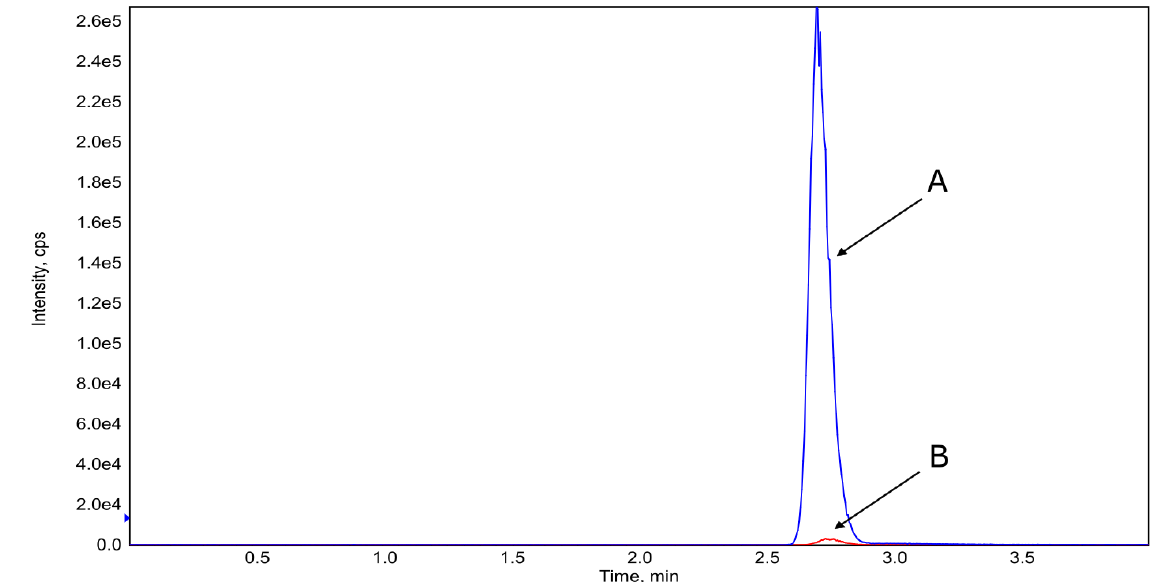
Figure 16. Overlay of HPLC-MS/MS amikacin chromatograms. A — AMI-1 filament after 7 days of immersion in water, B — AMI-2 filament after 7 days of immersion in water.